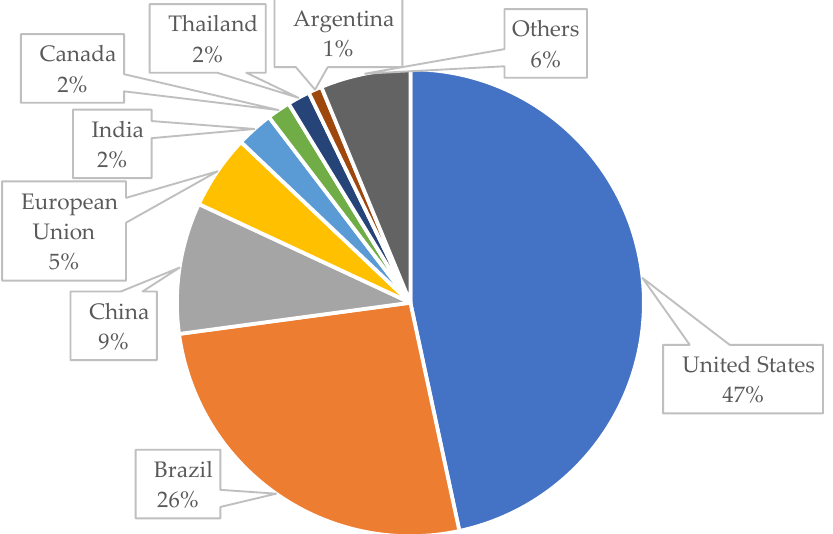
Figure 3. World ethanol production, 2020. Source: authors ’ composition based on [19].